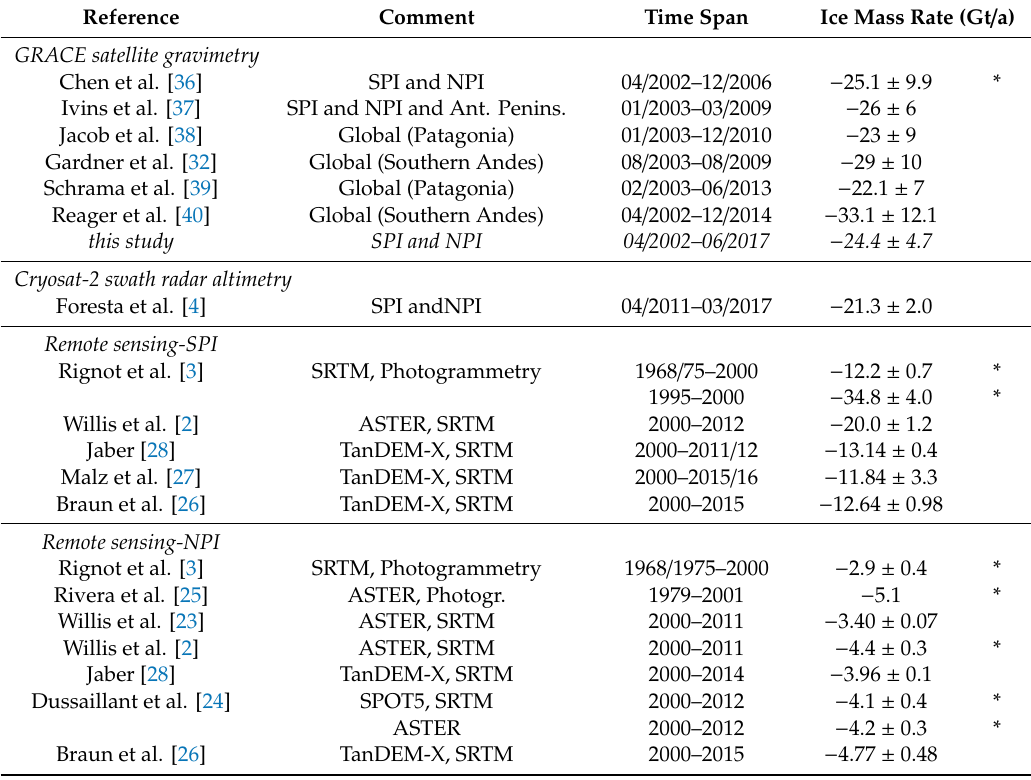
Table 1. Summary of ice mass change rates. The “comment” indicates the spatial extent for analyses using gravity recovery and climate experiment (GRACE) and Cryosat-2, and the data sources in the case of the remote sensing studies. SPI—Southern Patagonian Icefield; NPI—Northern Patagonian Icefield; SRTM—Shuttle Radar Topography